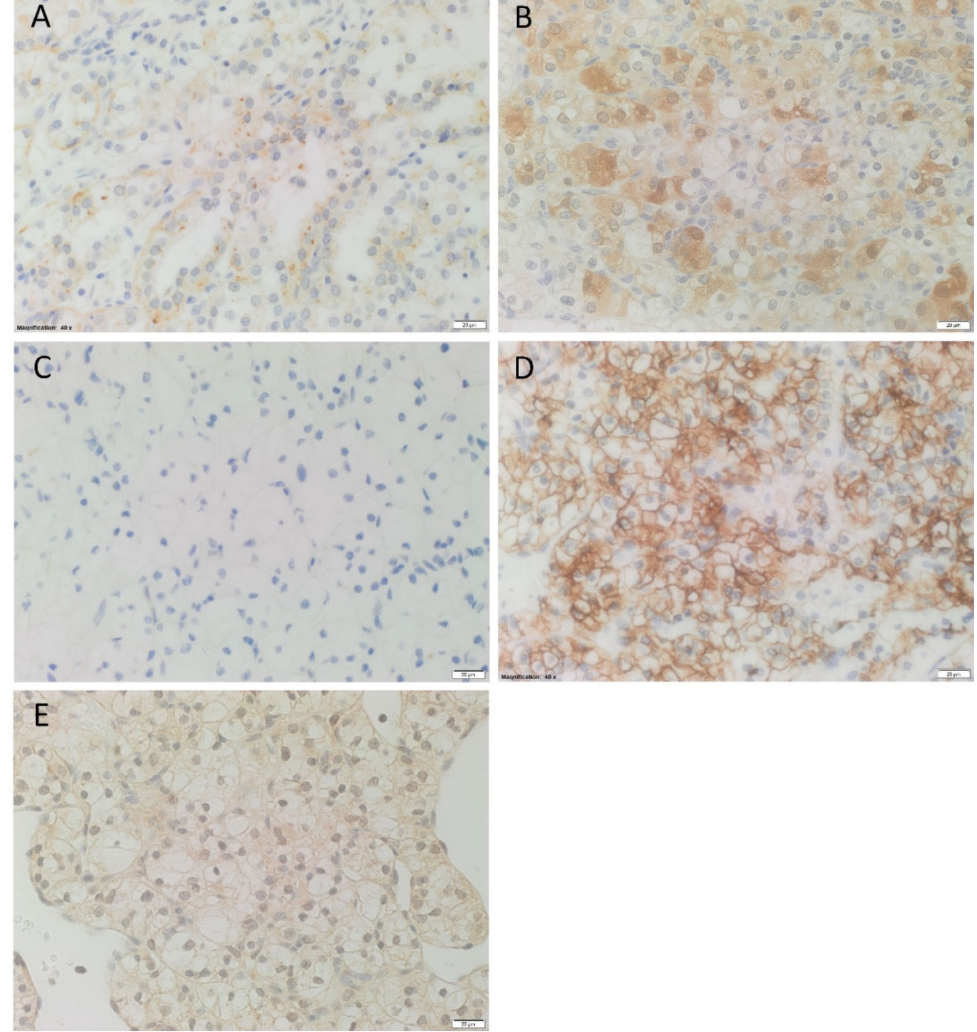
Figure 1. Representative immunohistochemical-stained images of renal clear cell carcinoma tissue samples. Renin ( A , brown) and PRR ( B , brown) showed cytoplasmic staining of the tumor cells. ACE ( C , brown) was not present within the tumor. ACE2 ( D , brown) showed mostly membranous, with some cytoplasmic, staining of the tumor cells. AT 2 R ( E , brown) was expressed in the cytoplasm and nucleus of the cells within the tumor. Nuclei were counterstained with hematoxylin ( A – E , blue). Original magnification: 400 × . Scale bar: 20 µ